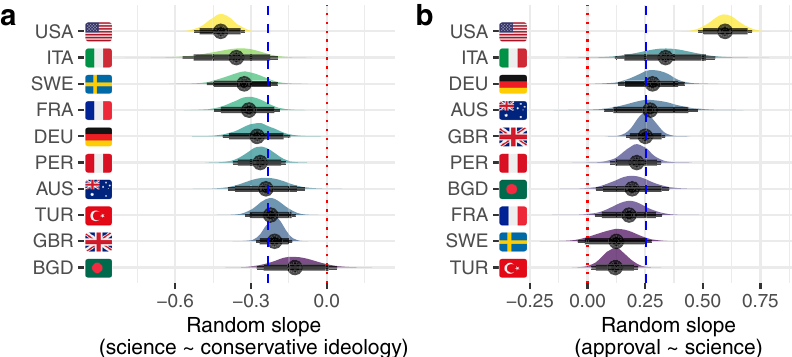
Fig. 3 Posterior samples for random slopes for the top 10 countries by sample size. a The negative effect of conservative ideology on trust in science and b the positive effect of trust in science on individual approval. Fixed effects shown with dashed blue lines and 0 shown with dotted red lines. AUS: Australia; BGD: Bangladesh; DEU: Germany; FRA: France; GBR: United Kingdom; ITA: Italy; PER: Peru; SWE: Sweden; TUR: Turkey; USA: United States of